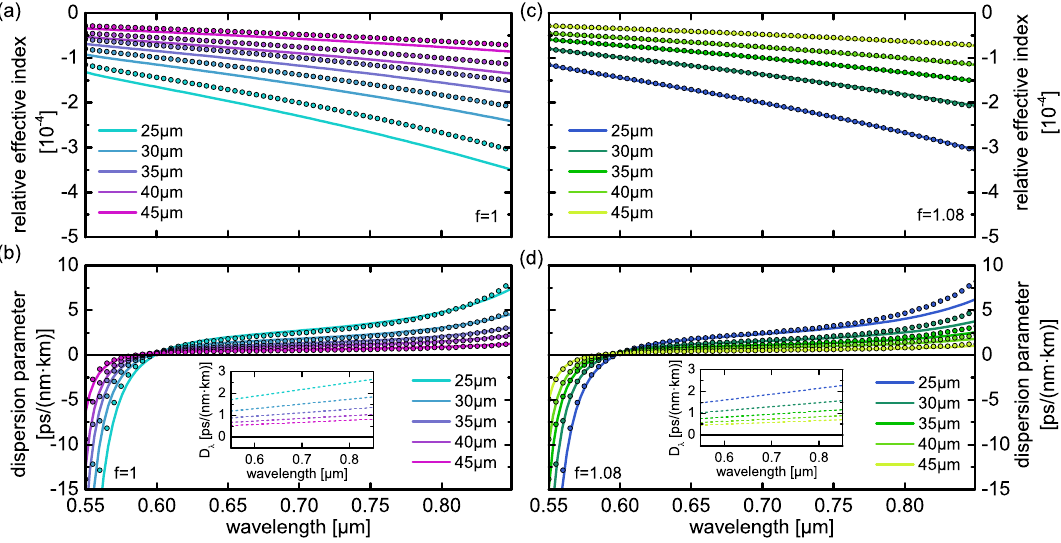
Figure 4. Spectral distributions of real part of the effective index (top row) and group velocity dispersion (bottom row) for different central core diameters of 2 R = 25 − 45 µ m ( a , b ) excluding and ( c , d ) including the core diameter correction factor). The symbols represent data from the FEM simulations of the RTF geometry ( d = 20 µ m, w = 0.5 µ m, N = 6), and the lines are calculated from the analytical